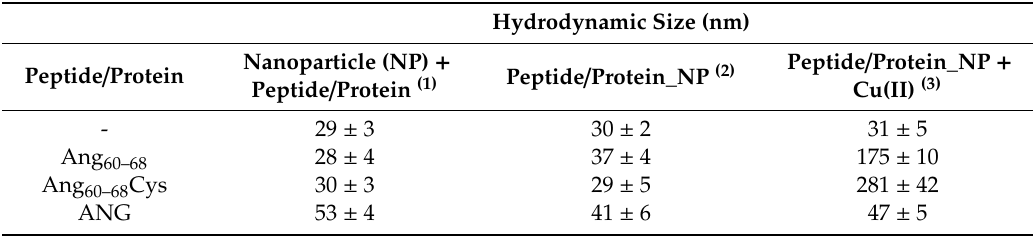
Table 1. Hydrodynamic size of the di ff erent NPs either before or after the functionalisation with the peptides or the protein, and after the addition of 20 µ M CuSO 4 aqueous solution.